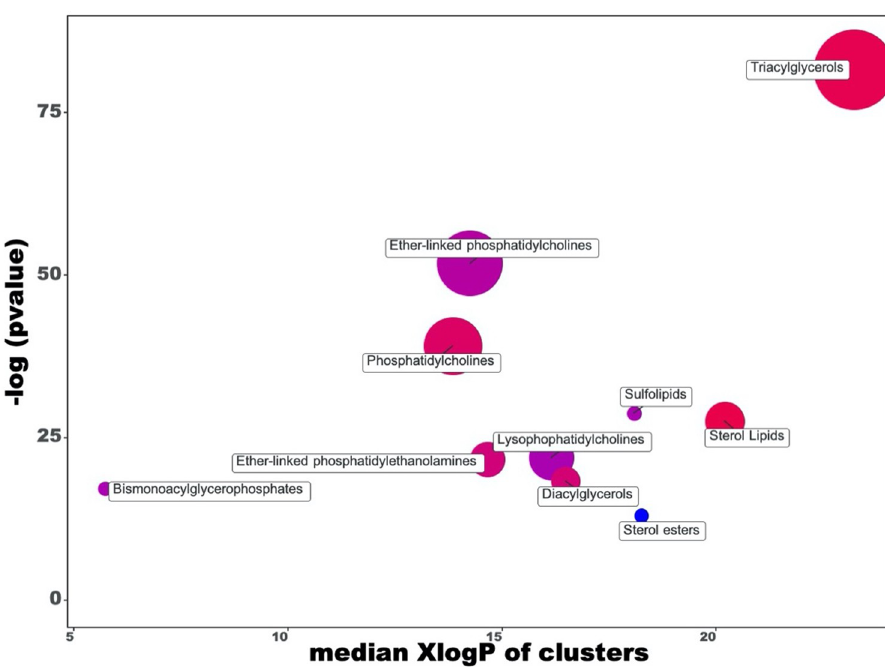
Fig 3. ChemRICH set enrichment statistics plot considering the comparison L vs CTRL diets. Each node reflects a significantly altered cluster of metabolites. Enrichment p -values are given by the Kolmogorov–Smirnov test. Node sizes represent the total number of metabolites in each cluster set. The node color scale shows the proportion of increased (red) or decreased (blue) compounds in L-diet compared to CTRL. Purple-color nodes have both increased and decreased